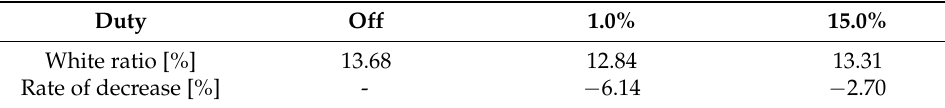
Table 2. Snow accumulation test (standard model) [Result_2].